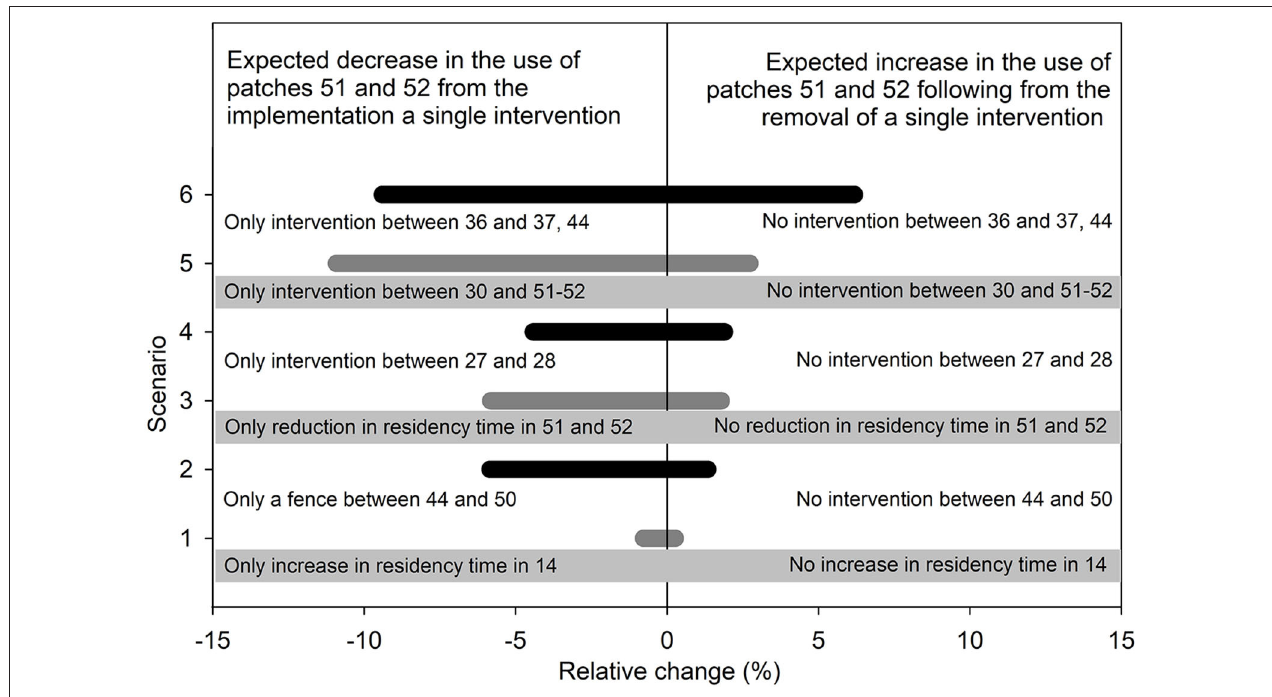
FIGURE 5 | Predicted impact of implementing a single intervention among those displayed in Figure 4B on the combined use of the two agricultural patches displayed in Figure 4A , together with predicted impact of removing a single intervention among those displayed in Figure 4B on the combined use of the two agricultural patches displayed in Figure 4B . The text on gray background refers to the gray bars, where the text on the white background refers to the black